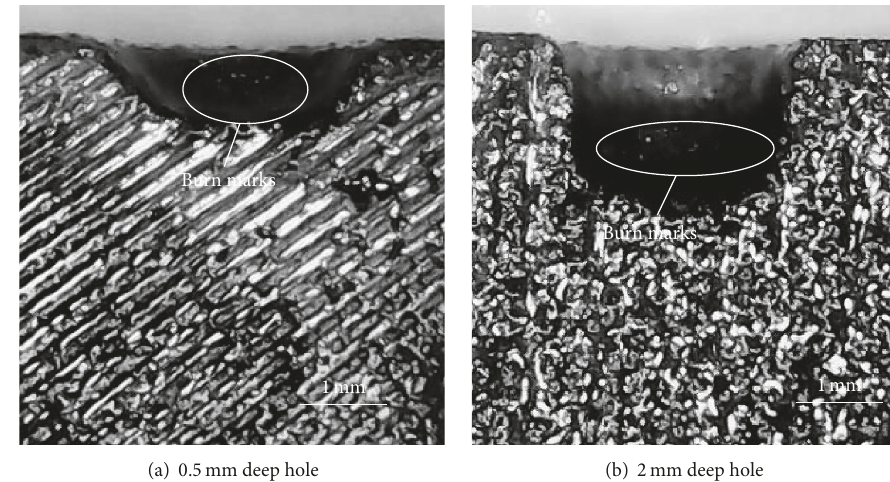
Figure 24: The cross section image of machined holes without